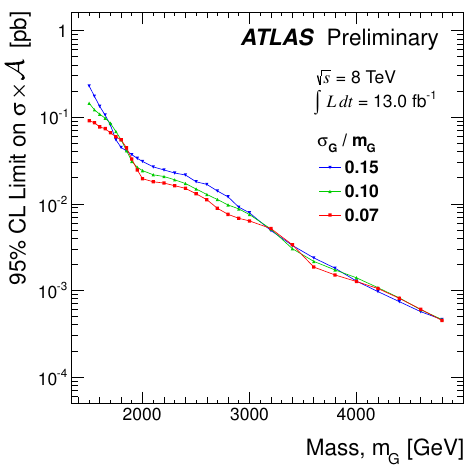
Figure 4. 95% C.L. limits on σ × A for simplified gaussian dijet resonance models. Limits are reported for three di ff erent signal widths [4].